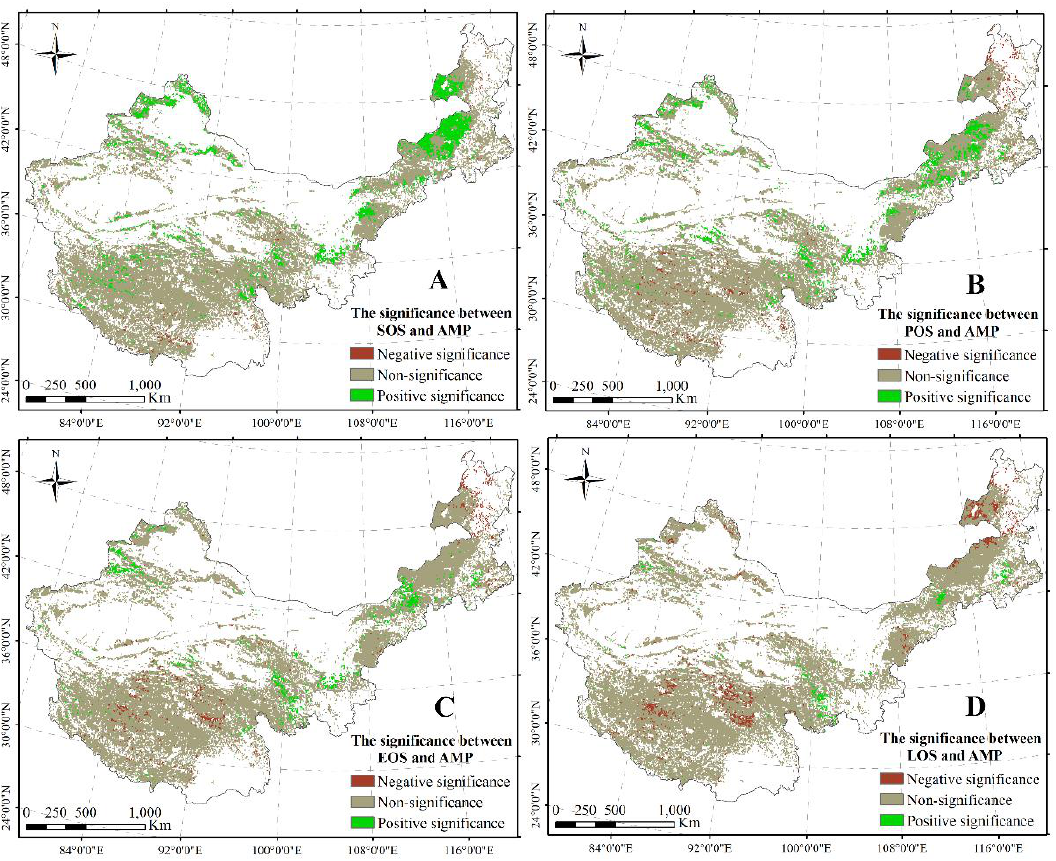
Figure 6. Significant correlations between SOS and AMP ( A ); between POS and AMP ( B ); between EOS and AMP ( C ); and between LOS and AMP ( D ). The significance level is 0.05.